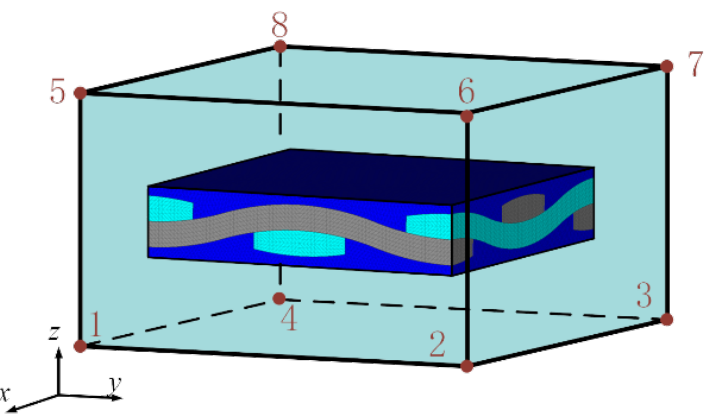
Figure 10. Element stress in X direction at the fatigue hot spots of the macro model.